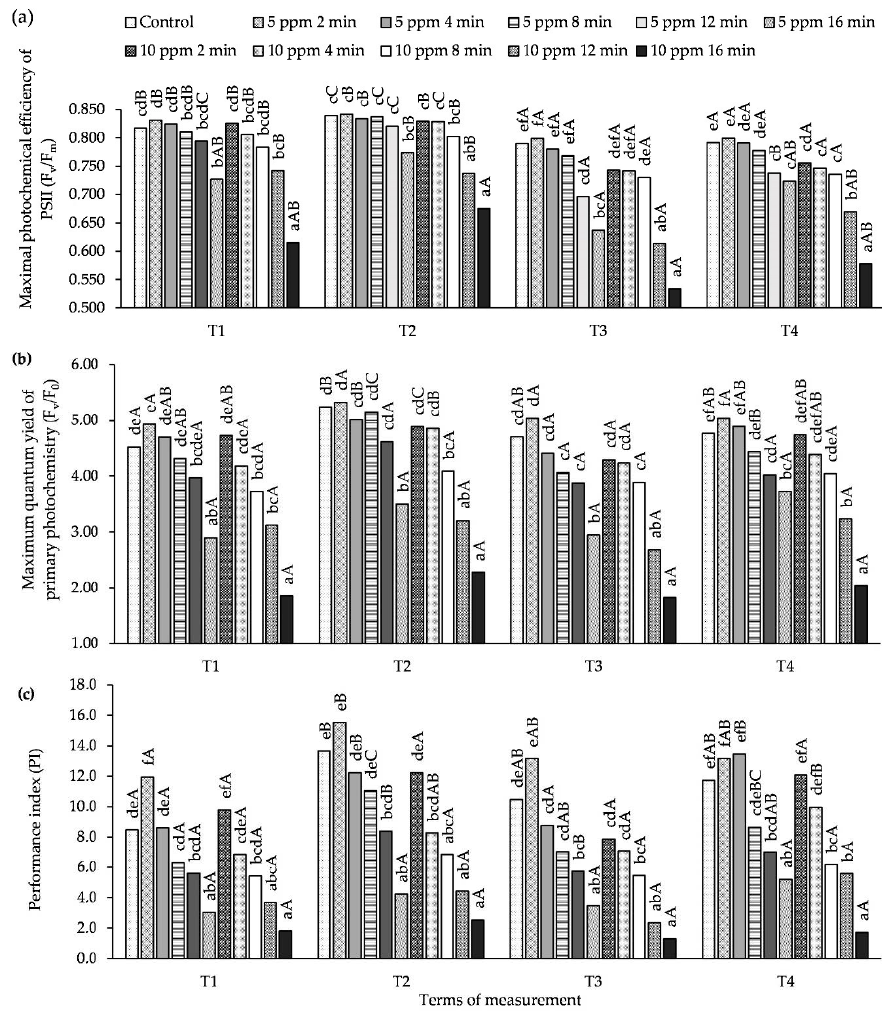
Figure 3. Changes in Chl fluorescence parameters in potato leaves depending on O 3 concentration, exposure time and measurement terms (T1—1st day after the 1st fumigation, T2—7th day after the 1st fumigation, T3—1st day after the 2nd fumigation, T4—7th day after the 2nd fumigation): ( a ) F v /F m - maximal photochemical efficiency of Photosystem II (PSII), ( b ) F v /F 0 -maximum quantum yield of